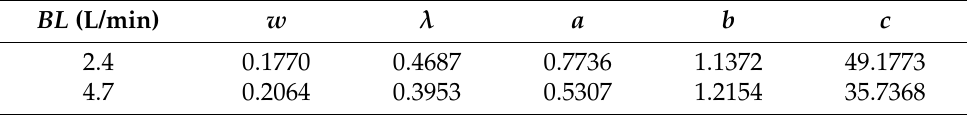
Table 2. EGG parameters for thermally uniform salty water